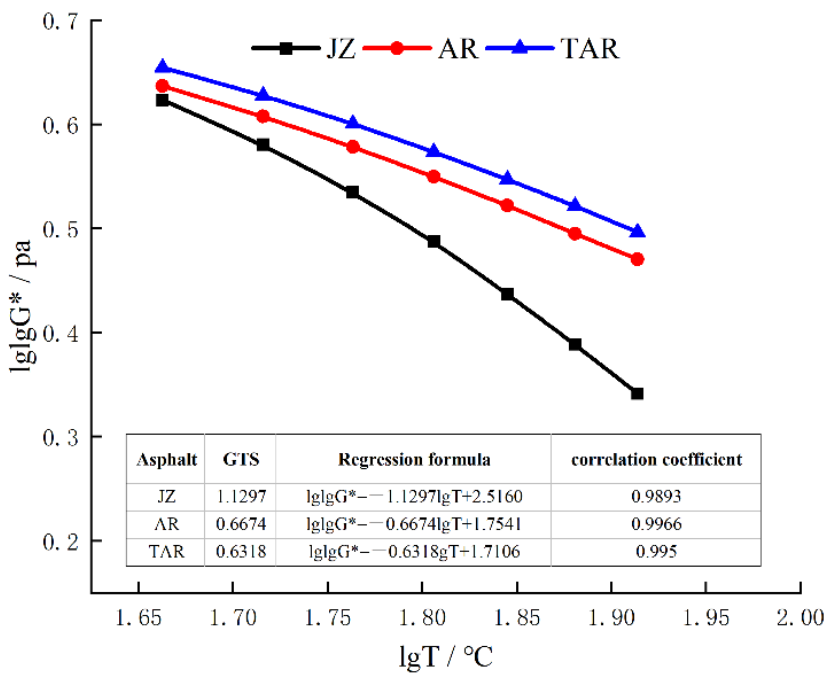
Figure 15. The variations of complex modulus G* double logarithm with temperature logarithm.